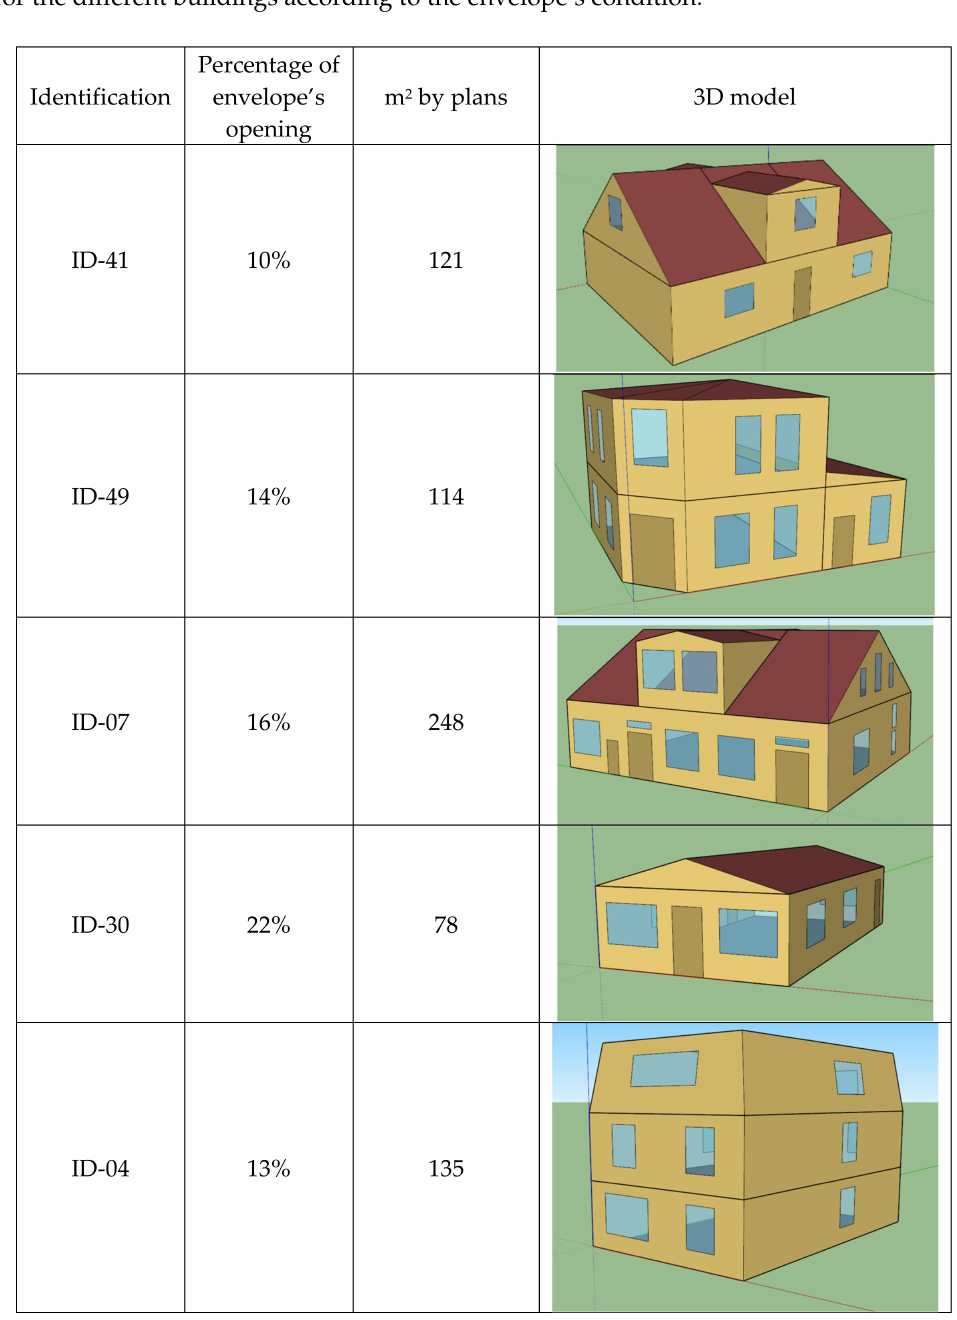
Figure 6. Simplified characterization of the case studies under thermal energy